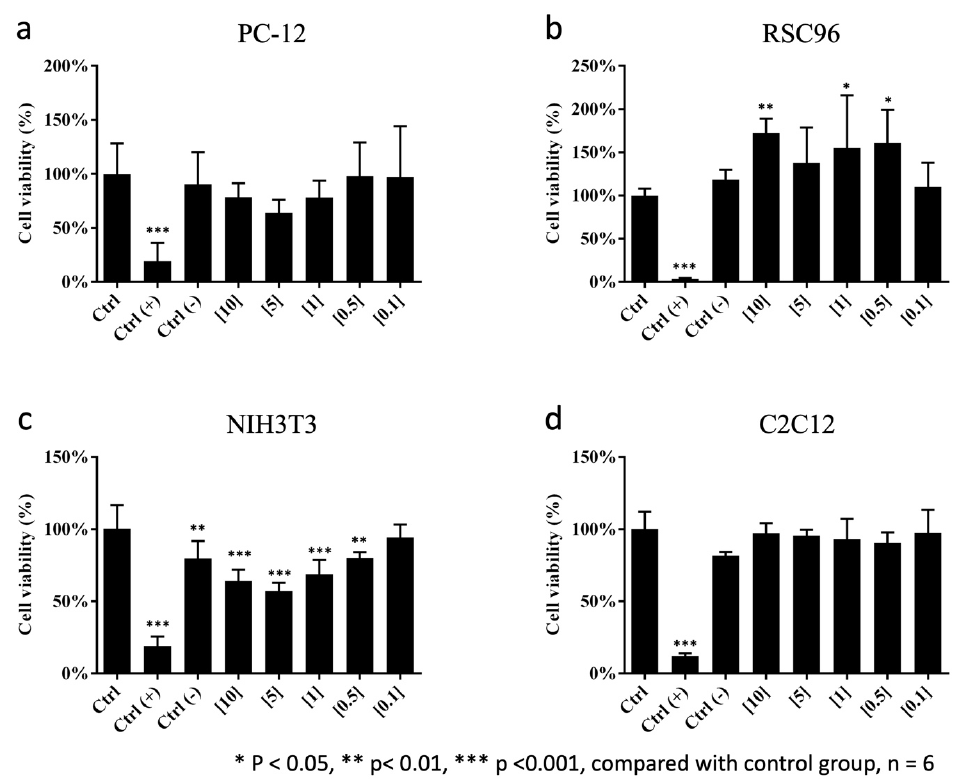
Figure 5. Viability of cells cultured in extraction media of CMC/BSP (10, 5, 1, 0.5, and 0.1 mg/mL)/RES dual-layer sponges. Figure 5. ( a ) PC12; ( b ) RSC96; ( c ) NIH/3T3; ( d ) C2C12. (Figure 7). Based on the above results, 0.1 mg/mL CMC-BSP-RES sponge was selected for use in the subsequent experiments. No significant differences were found in RSC96 Schwann cells and C2C12 myoblasts when cultured in different extractions of the CMC-BSP-RES sponge (Figure 6b,d).